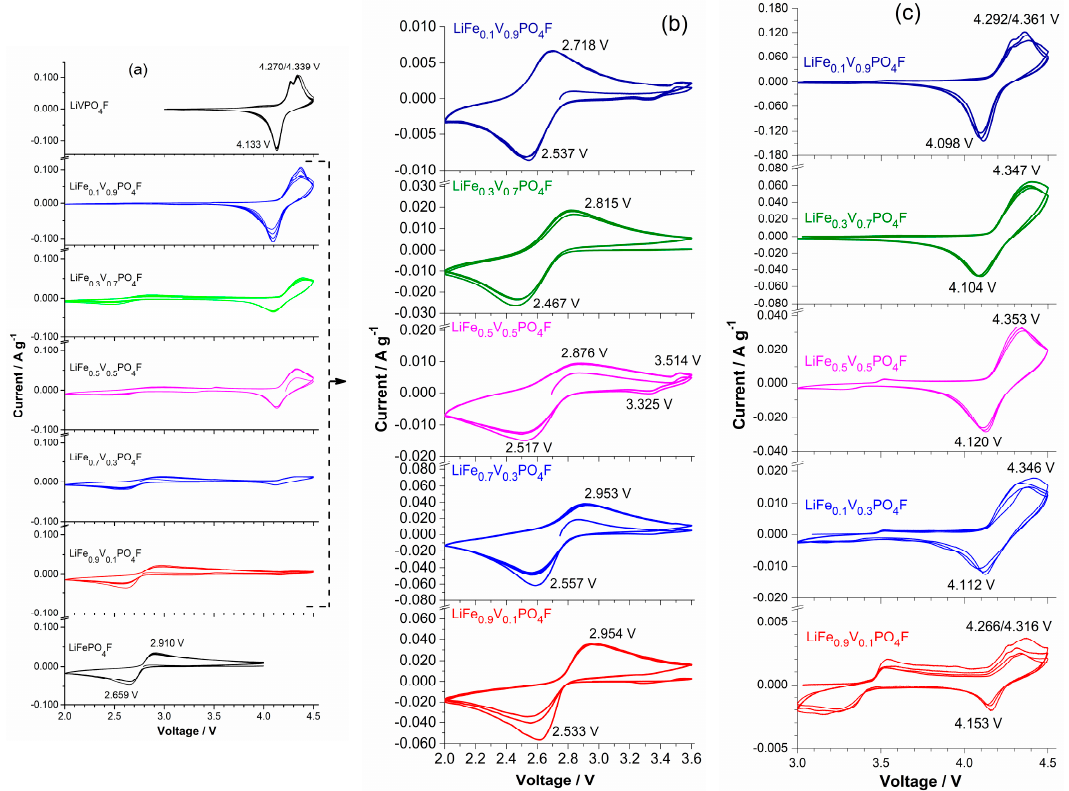
Figure 4. Cyclic voltammetry (CV) curves of LiFe 1 − x V x PO 4 F ( x = 0, 0.1, 0.3, 0.5, 0.7, 0.9, 1) cells with the same sweep rate of 0.1 mV s − 1 for five cycles in the range of 2.0–4.5 V ( a ), 2.0–3.6 V ( b ) and 3.0–4.5 V ( c ). With the exception of the starting half cycle, all of peak positions are from the second cycle.